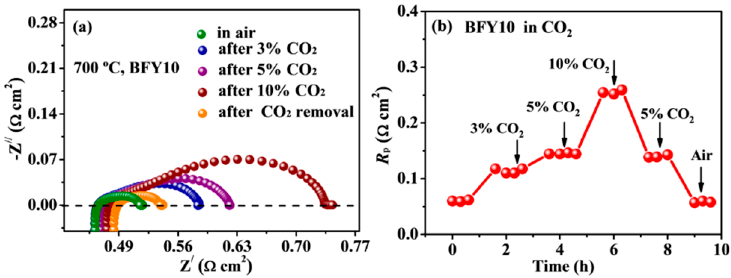
Figure 6. ( a ) Impedance spectra and ( b ) short-term stability of BFY10 cathode in various CO 2 concentrations at 700 °C.